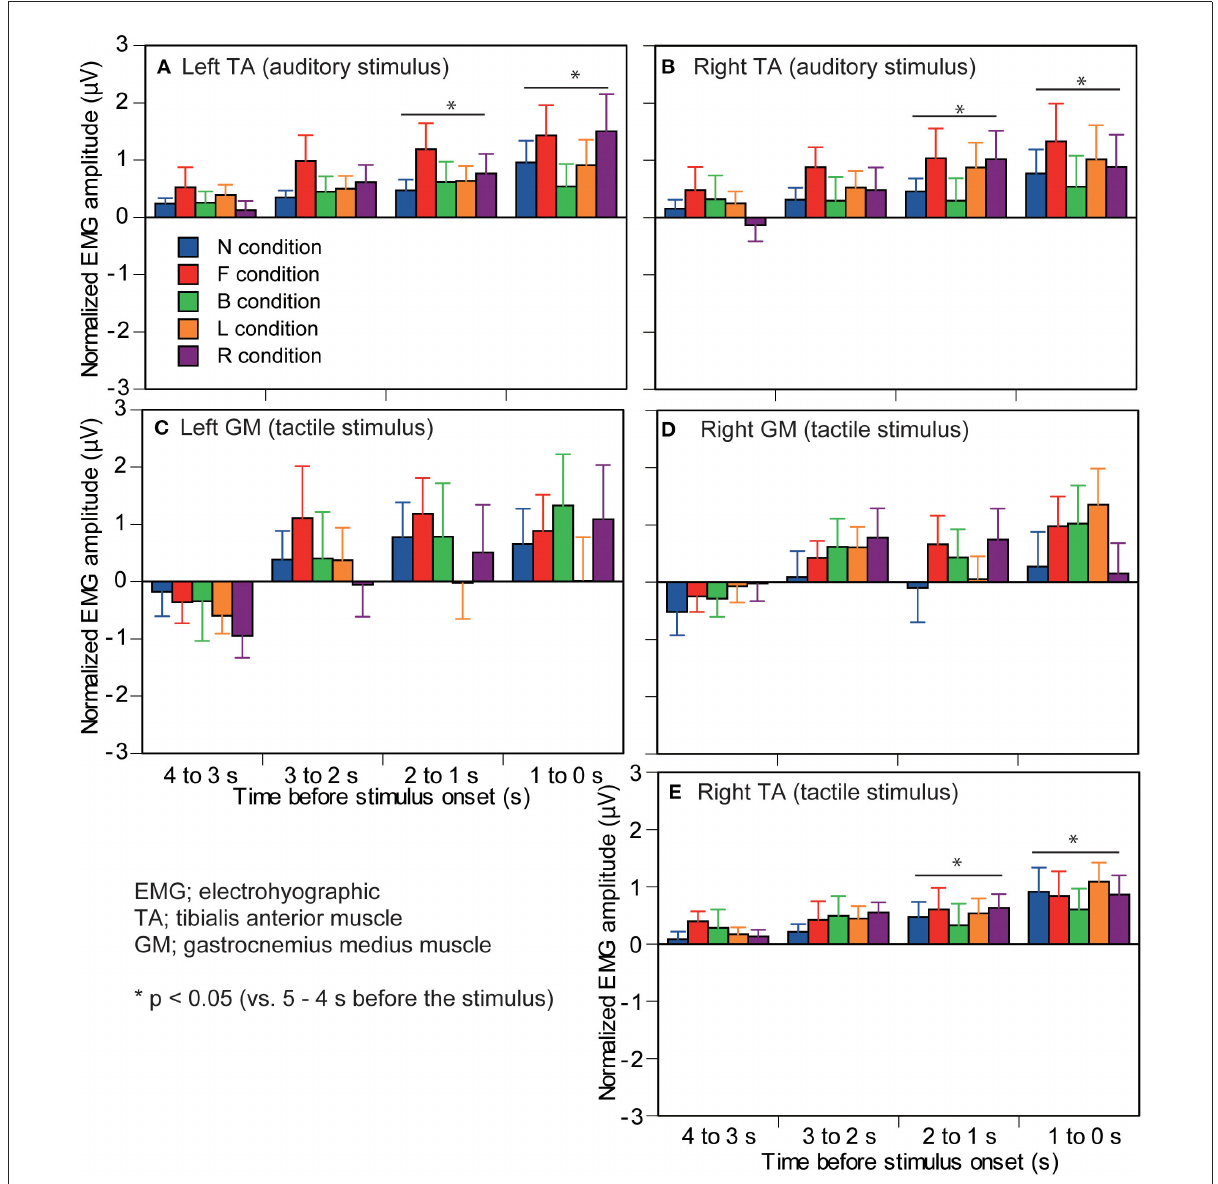
FIGURE6 Effect of predicting the stimulus site on the EMG amplitude in which significant interaction between the main effects is not found. The left panels are the muscles in the left ankle (A,C) and the right panels are the muscles in the right ankle (B,D,E) . Upmost panels are the muscles in the auditory stimulus trial block (A,B) , and the other panels are the muscles in the tactile stimulus trial block (C–E) . The data are normalized by subtracting the average value at 1–0s before the onset of the visual cue (5–4s before the stimulus) from the values averaged at each 1s in the time window between 4 and 0s before the stimulus. Bars indicate the mean, and error bars indicate standard errors of the mean. Asterisks indicate significant differences from mean amplitude at the time 5–4s before the stimulus (1–0s before the visual cue) in the same condition. N, trials with the cue predicting non-stimulation; F, trials with the cue predicting the stimulus to the forehead; B, trials with the cue predicting the stimulus to the back of the head; L, trials with the cue predicting the stimulus to the left side of the head; R, trials with the cue predicting the stimulus to the right side of the head. EMG,